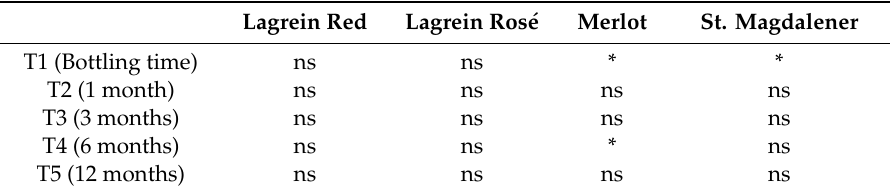
Table 5. Triangle test. ns: not significant; *: significant ( p < 0.05). Lagrein Red Lagrein Ros é Merlot St. Magdalener